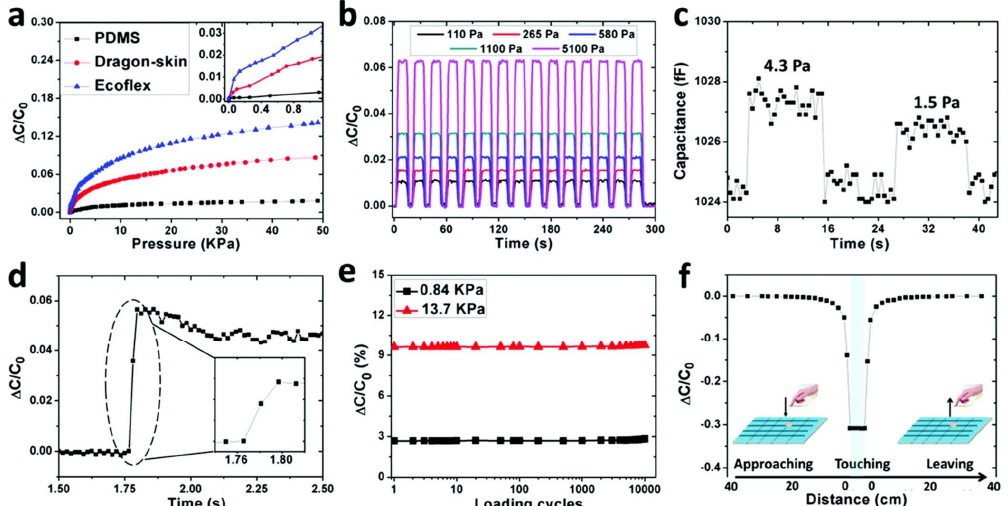
Figure 17. ( a ) Pressure versus capacitance of fiber sensors embedded in various PDMS dielectric layers. Inset shows response within low pressure regions of 1 kPa; ( b ) capacitive response of